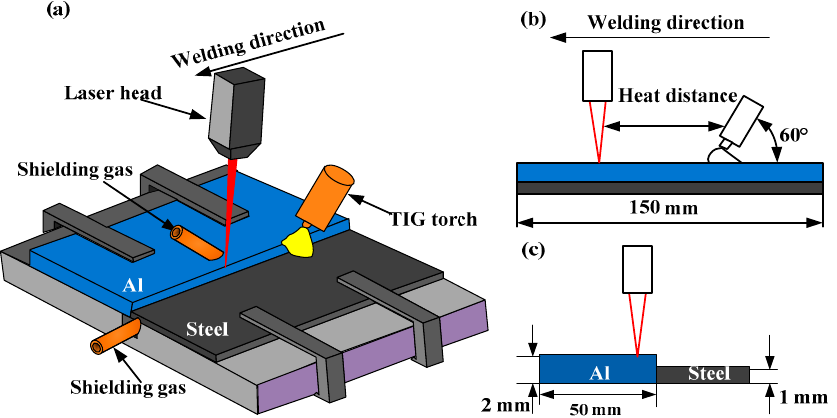
Figure 1. Schematic diagram of the arc-assisted laser welding; ( a ) overview, ( b ) front view, and ( c ) side view.